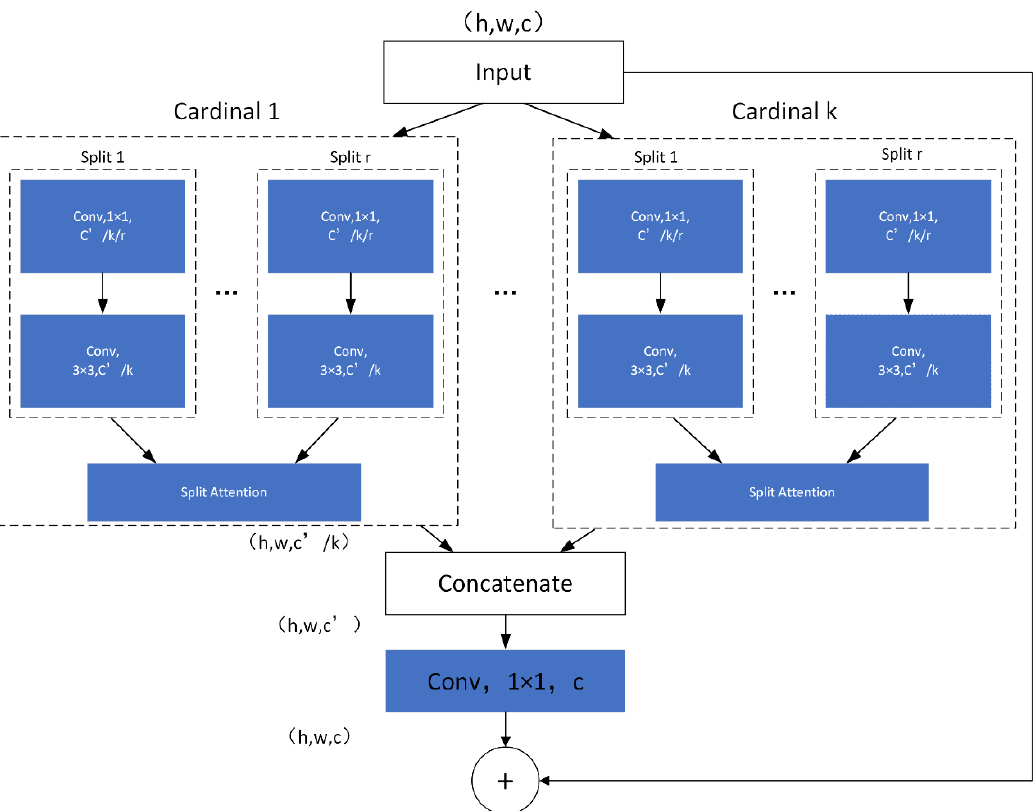
Figure 2. ResNest Block structure diagram.